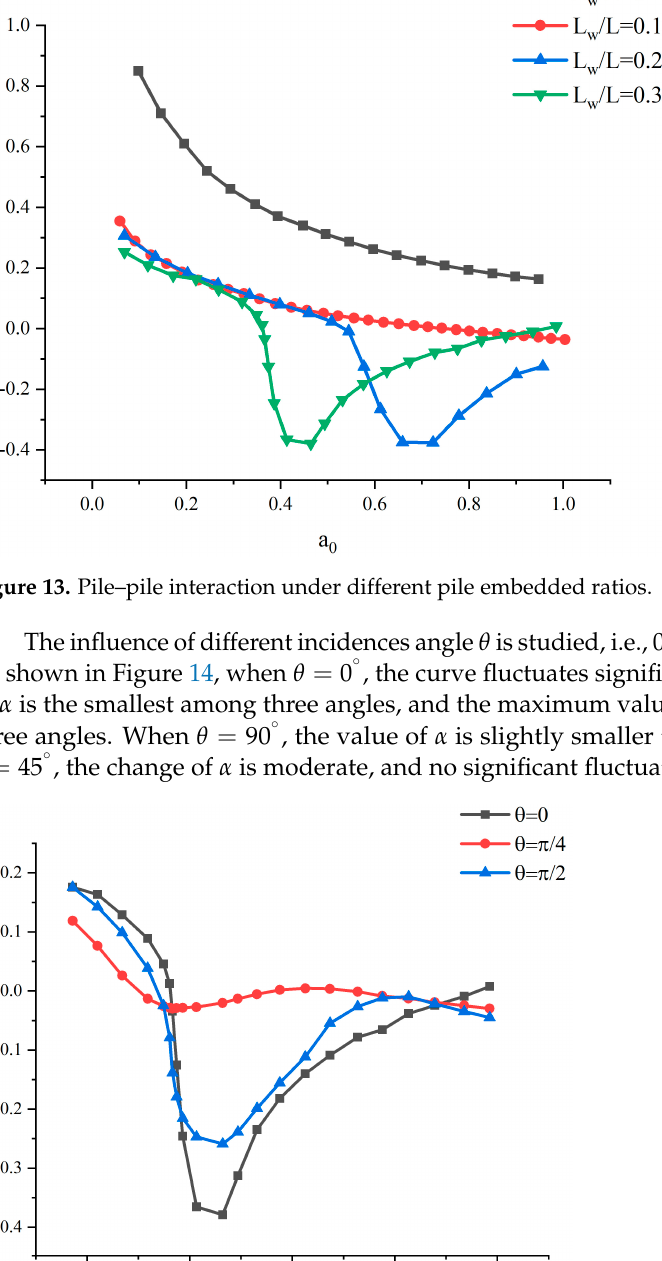
Figure 14. Pile–pile interaction under different incidence angles.